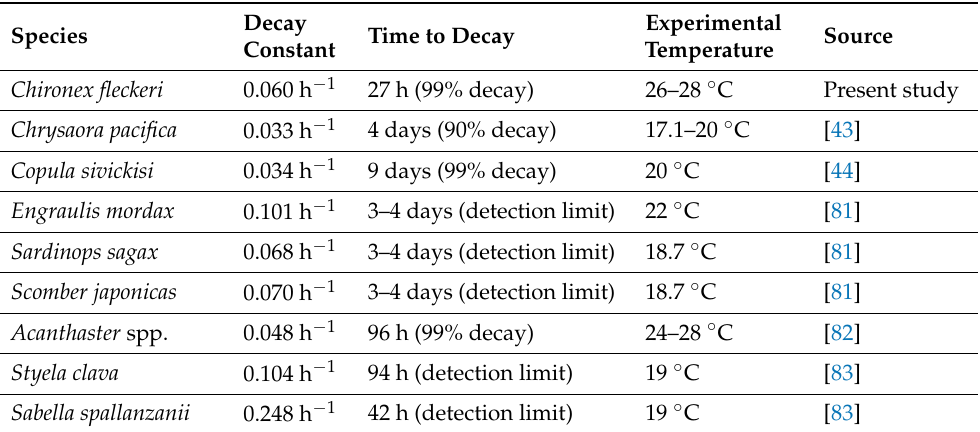
Table 4. Reported Decay Rates of Other Jellyfish and Marine